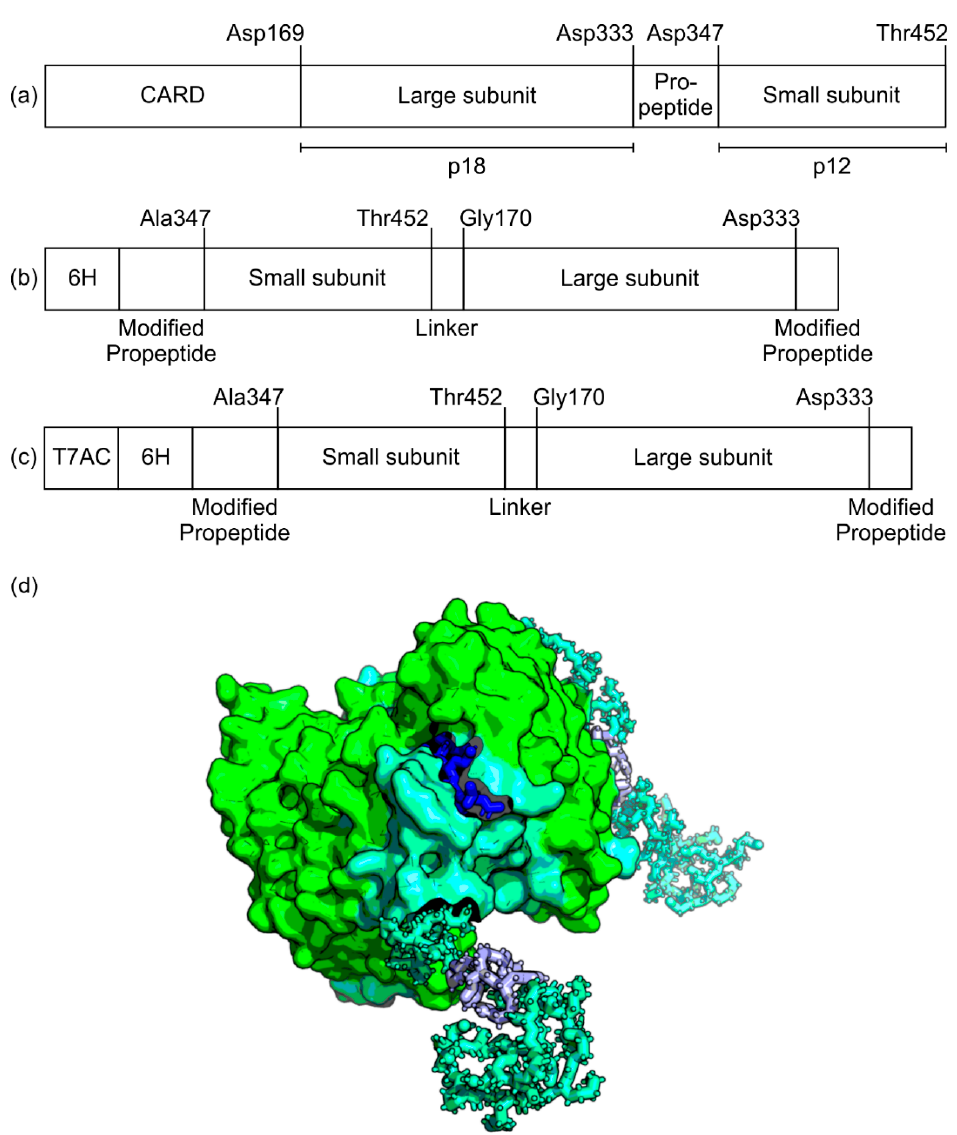
Figure 1. ( a ) schematic representation of wtCasp2. Aspartate residues critical for activation are annotated. Length of subunits is not true to scale. By cleavage after Asp333, the fully active enzyme is formed, and the mature caspase is obtained by two further cleavage events at Asp169 and Asp347 [47]. Cleavage at Asp347 reduces the small subunit from a p13 to a p12; this, however, does not further increase activity [18]. ( b ) In the cp variant, the order of subunits is reversed. The pro-peptide before the small subunit is modified to avoid autocatalytic cleavage. ( c ) For T7AC-cpCasp2, the T7AC tag is added N-terminally; ( d ) crystal structure of a T7AC-cpCasp2 dimer, based on PDB structure 1PYO with added N-terminal tags [14]. The large subunit is green, while the small subunit is turquoise. The his-tag is shown in purple and a substrate peptide is shown bound to the active site in blue.